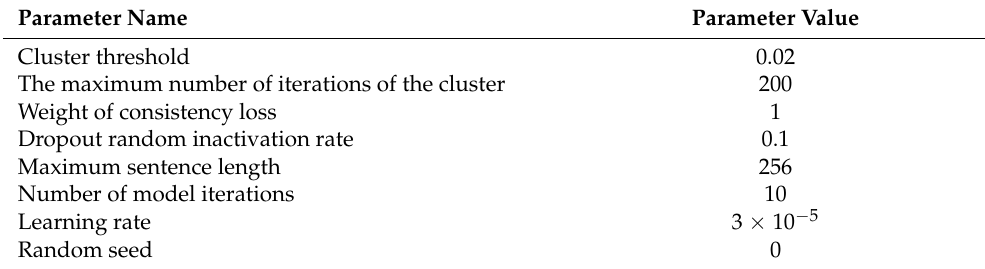
Table 1. Experiment settings.